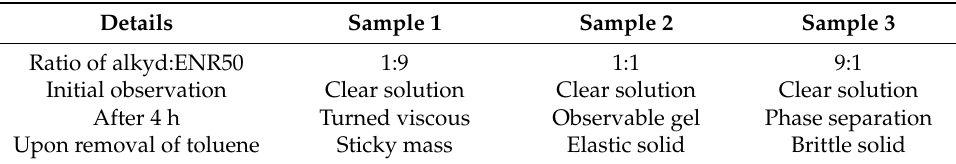
Table 1. The observed effects of reacting alkyd with ENR50 at different weight ratios in toluene at room temperature (around 27 ˝